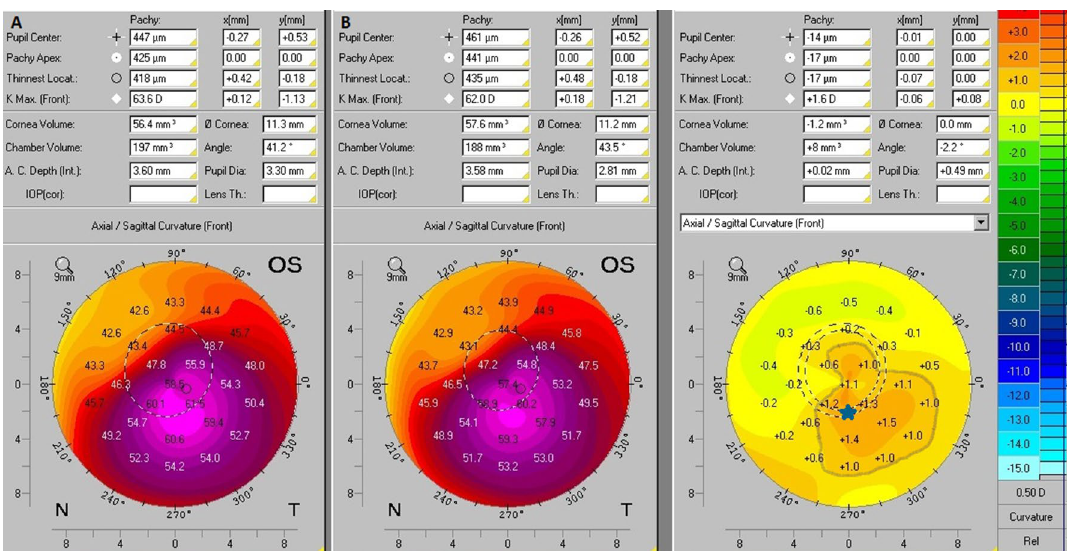
Figure 3. Anterior axial/sagittal curvature comparative maps of Pentacam HR images. In this case, the axial/ sagittal curvature maps had an interval of 12 months. In the initial exam ( B ) the Kmax was 62.0D and in the subsequent exam ( A ) the Kmax was 63.6D, so there was progression of + 1.6D in this variable (blue star). Moreover, the comparative map showed an increase of more than 1D in the anterior curvature outside the apical corneal zone, which is highlighted by the gray line, thus showing KCE